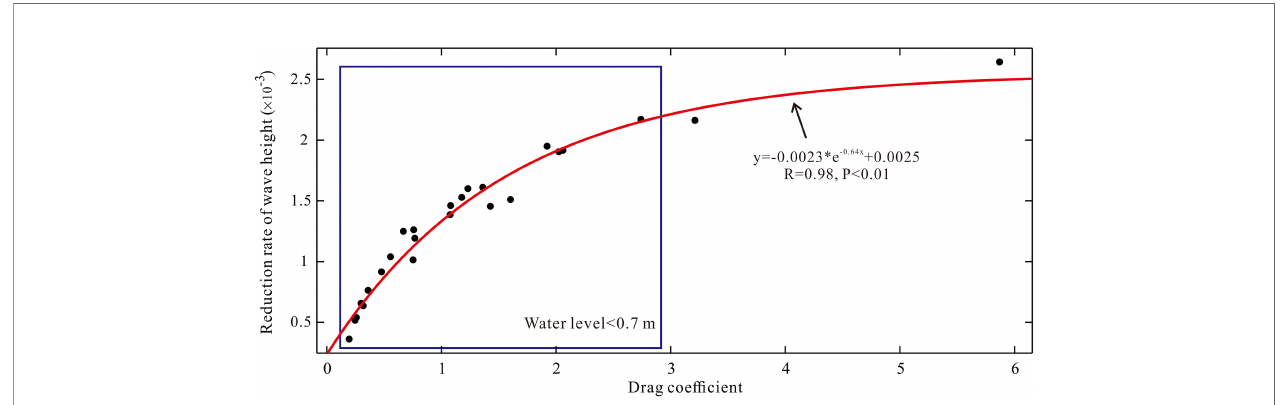
FIGURE 10 | Descriptions of the drag coef fi cient. A fi tting relationship is shown between the drag coef fi cient and wave height reduction rate. The fi tting formula is shown in the fi gure. The relationship when the water level is shallower than 0.7 m is shown in the